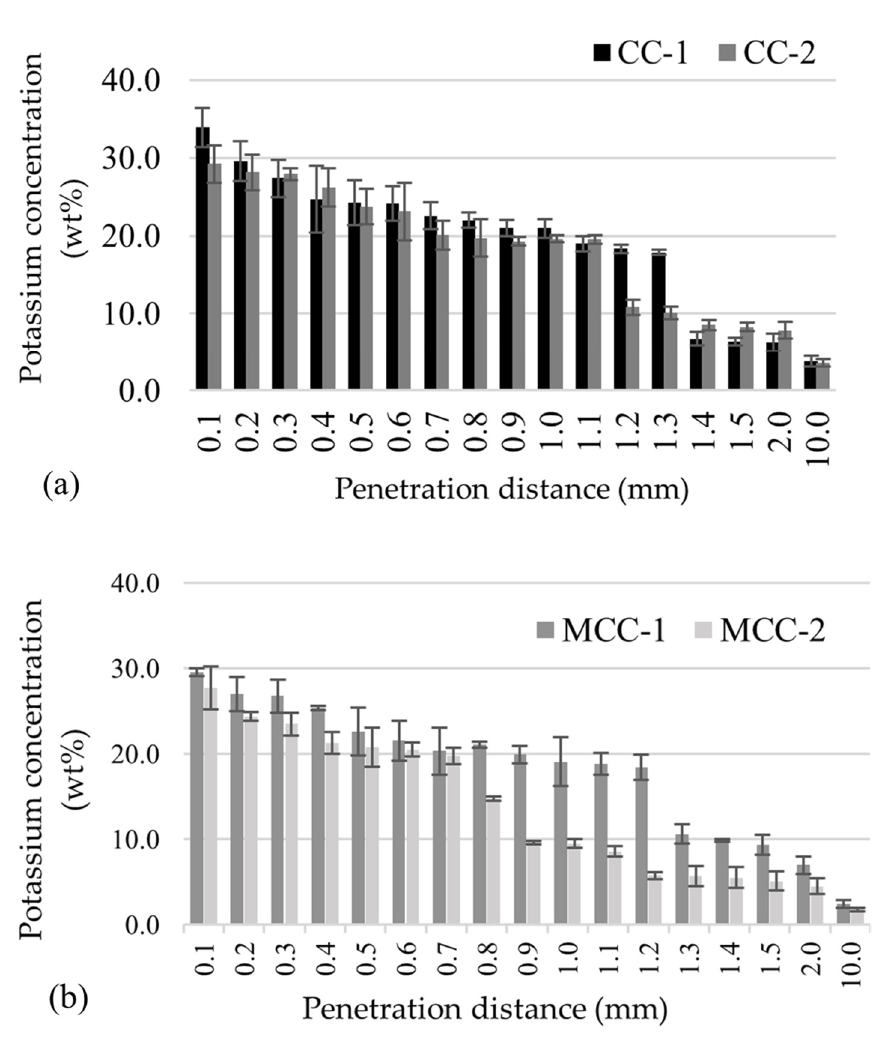
Figure 6. Potassium distribution in the surface layer of castable: ( a )—CC; ( b )—MCC. Table 3 provides information on the average values of the chemical elements after three cycles of alkaline resistance in the thickness of the protective layer recorded from the EDS analysis (last measurement before the significant decrease in potassium). Table 3. Percentage averages of major chemical elements in the protective layer after 3 cycles of potassium attack.